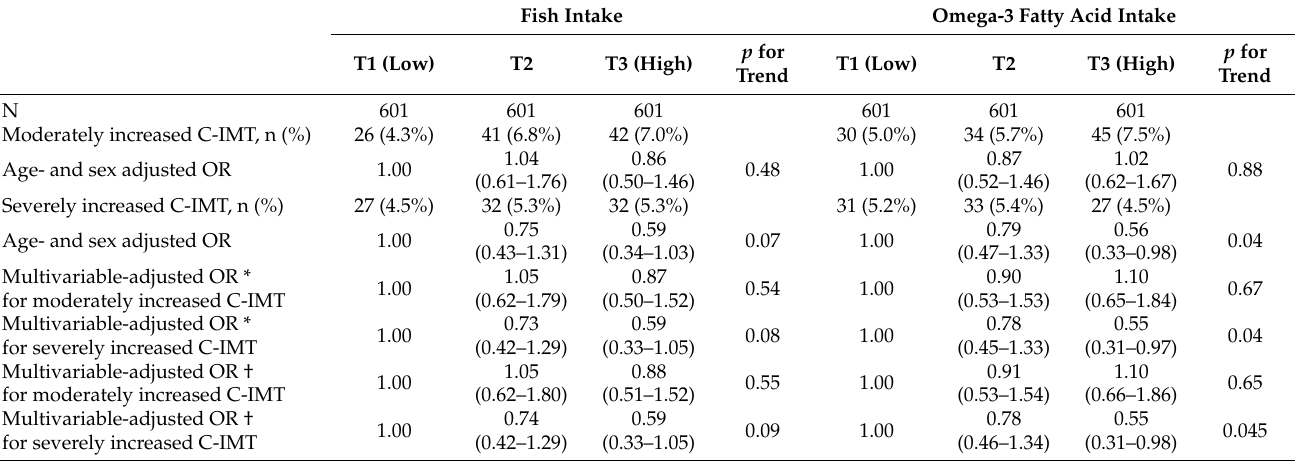
Table 3. Odds ratios (OR) and 95% confidence intervals (95% CI) of moderately and severely increased C-IMT from a multinomial logistic regression model, reported via fish and omega-3 fatty acid intake tertiles. Fish Intake Omega-3 Fatty Acid